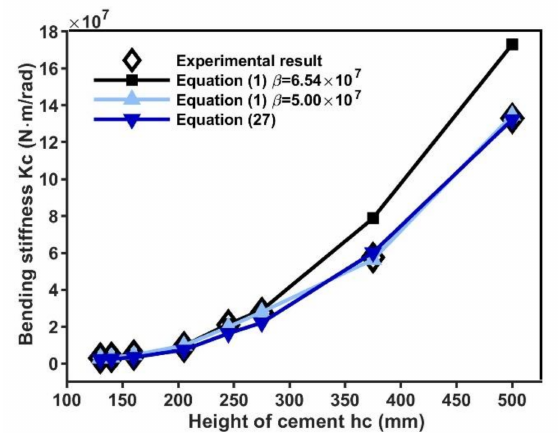
Figure 8. Comparison of bending stiffness results.